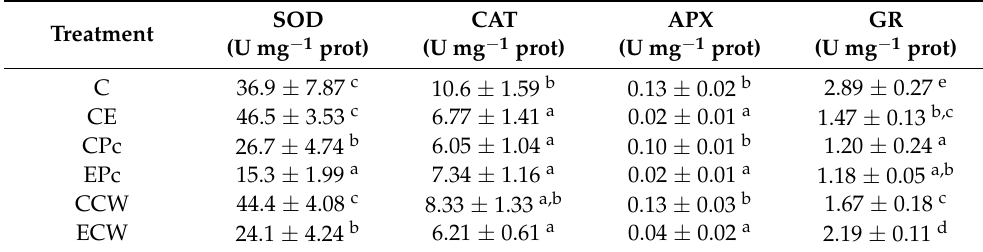
Table 7. Effect of soil treatments on the specific activity of antioxidant enzymes expressed in units mg − 1 protein. SOD: superoxide dismutase; CAT: catalase; APX: aspartate peroxidase; GR: glutathione reductase. Treatments: Soil sampled in the Chinampas area was used as control (C); soil contami- nated with endosulfan (CE); control soil bioremediated with Penicillium crustosum (CPc); endosulfan- contaminated soil, bioremediated with P. crustosum (EPc); control soil bioremediated with citric waste (CCW); endosulfan-contaminated soil, bioremediated with citric waste (ECW). Values represent the means of five replicas (five individual plants) followed by SD. Different letters in each column indicate significant differences between treatments, according to the Tukey test at the 99% confidence